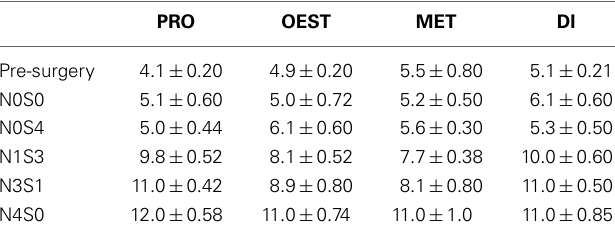
Table A4 | Response rates for von Frey test